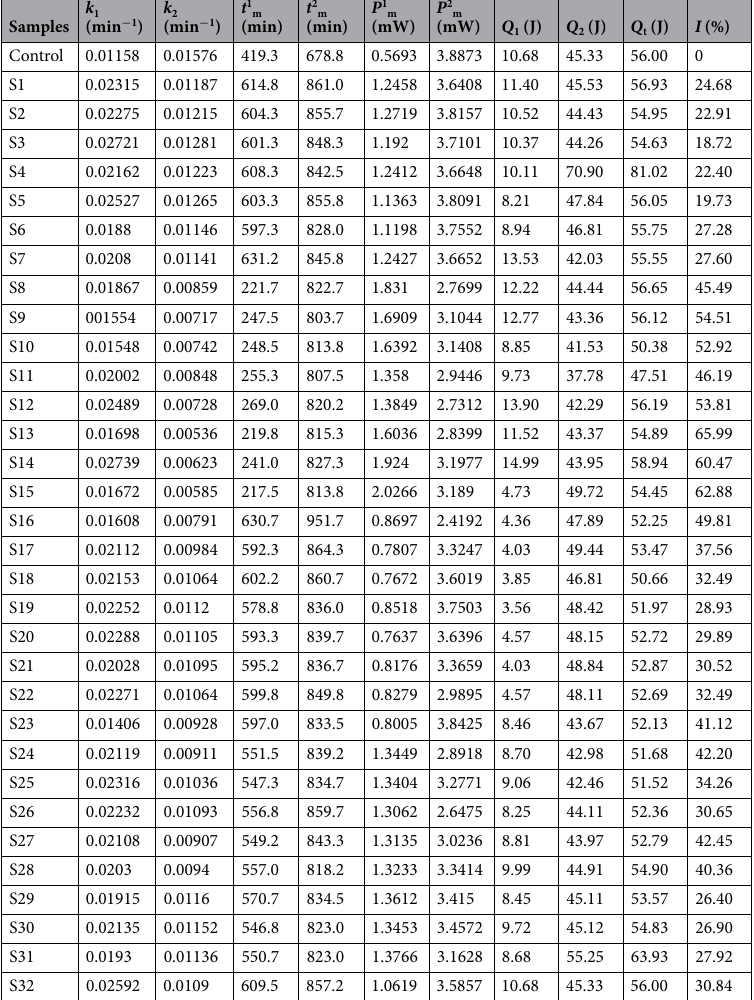
Table 1. Thermokinetic parameters obtained from the power-time curves of P . aeruginosa growth in the presence of 1000 μ g/mL of S . Miltiorrhizae from different